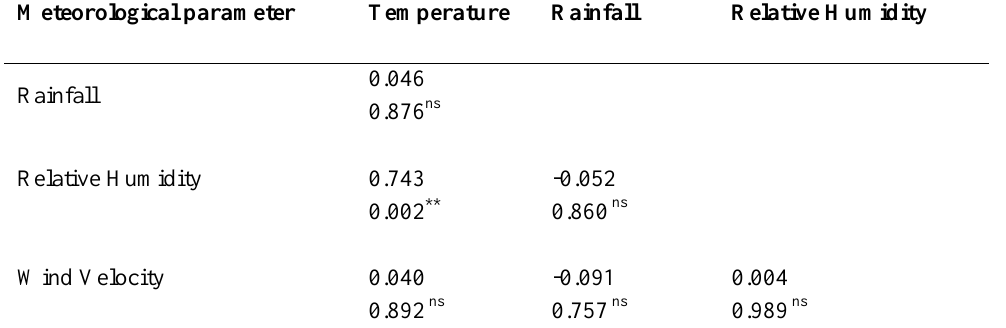
Table 2: Correlation analysis results (Pearson Correlation Coefficient and p values) amongst the meteorological